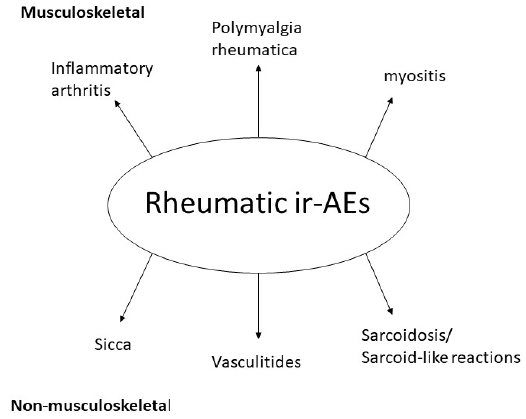
Figure 1. Main immune checkpoint inhibitor (ICI)-induced rheumatic syndromes.